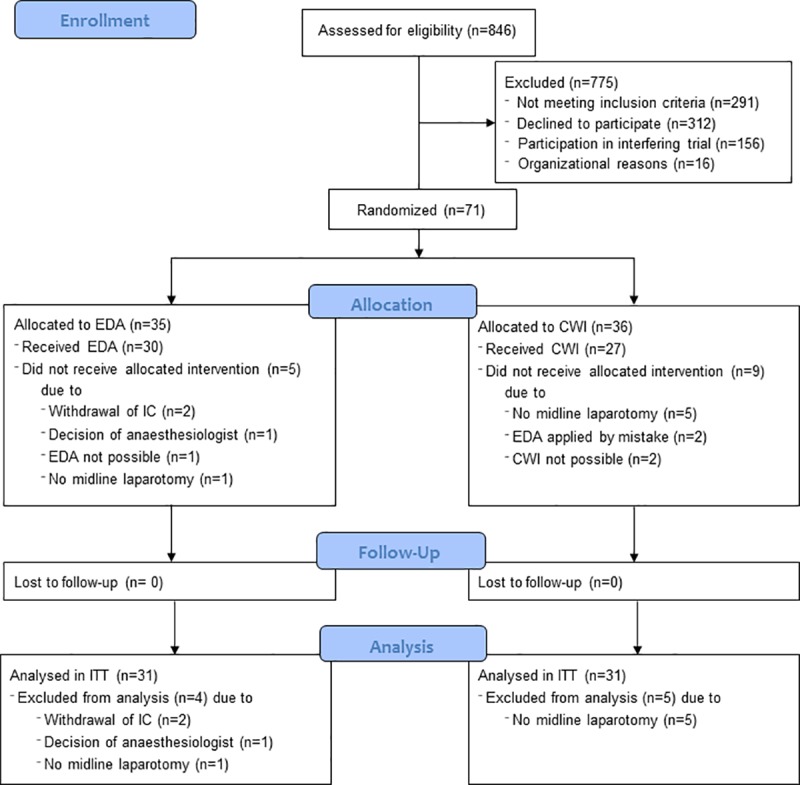
CONSORT flow-chart.